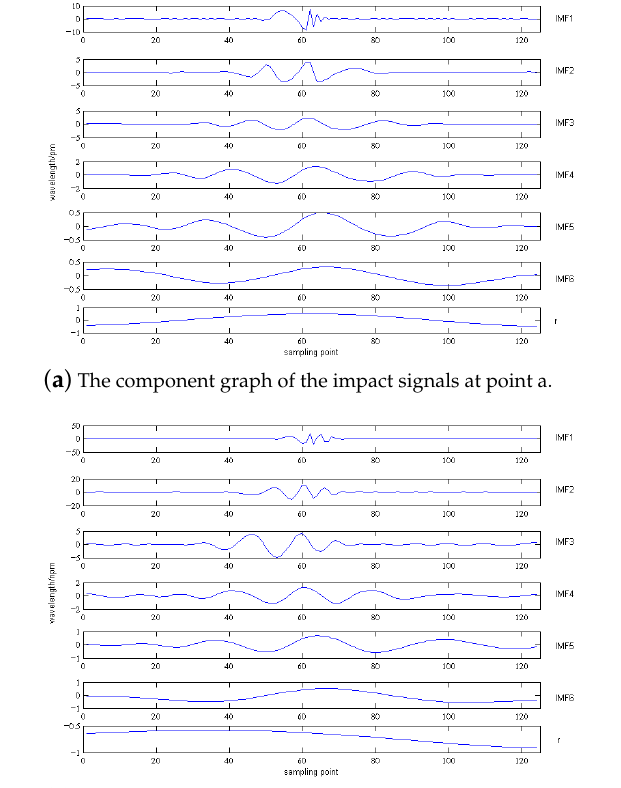
( d ) The component graph of the impact signals at point d. Figure 11. The EMD component graph of the impact signals at points a–d. Table 2. Correlation table for each order IMF of the EMD